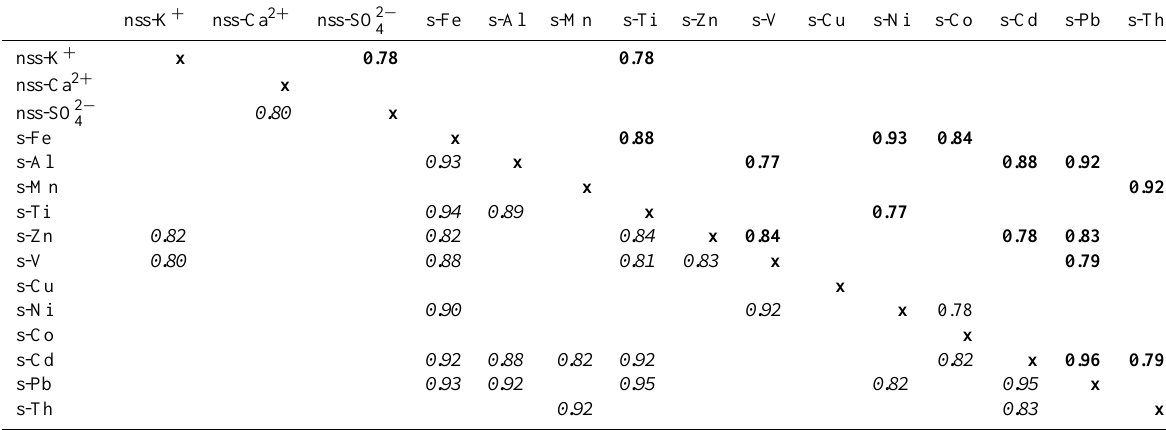
Table 4. Spearman’s rank correlation matrix for selected parameters measured during M91. Upper right quadrant (bold) shows significant correlation coefficients ( p <0.01) obtained from the entire data set. Lower left quadrant (italics) shows significant correlation coefficients ( p <0.01) obtained after removing sample TM09.